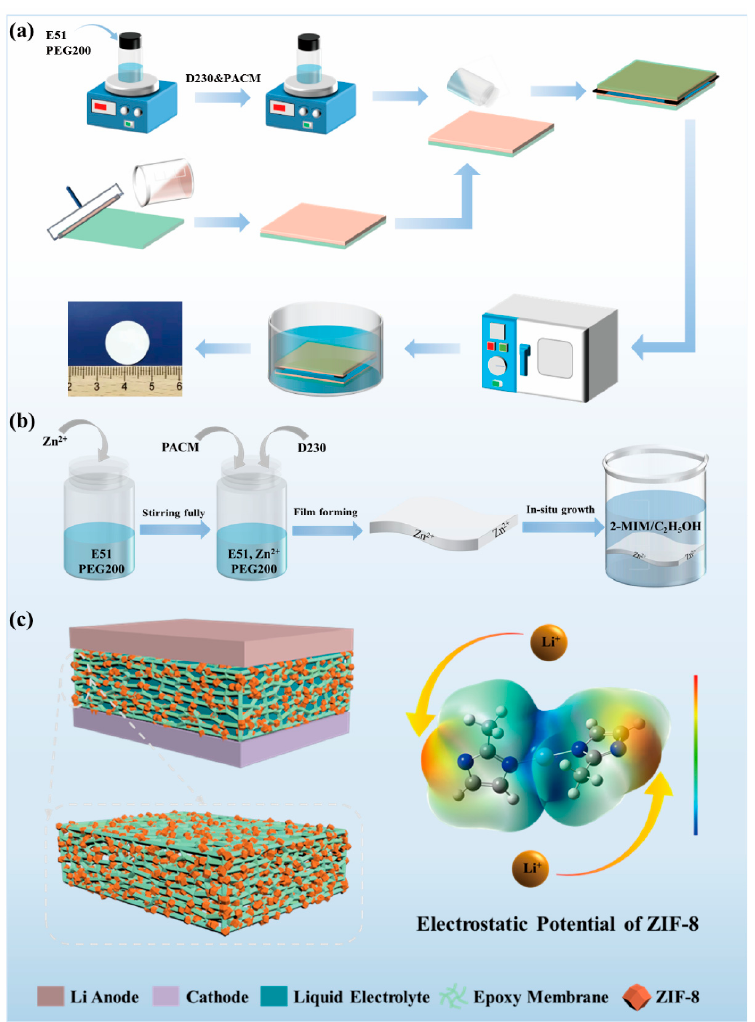
Figure 1. Schematic diagram of ( a ) the preparation of PEME-x membranes; ( b ) the preparation of PEME-3:7/ZIF-8 composite membranes, and ( c ) Li metal battery with PEME-3:7/ZIF-8 electrolyte and electrostatic potential of ZIF-8.